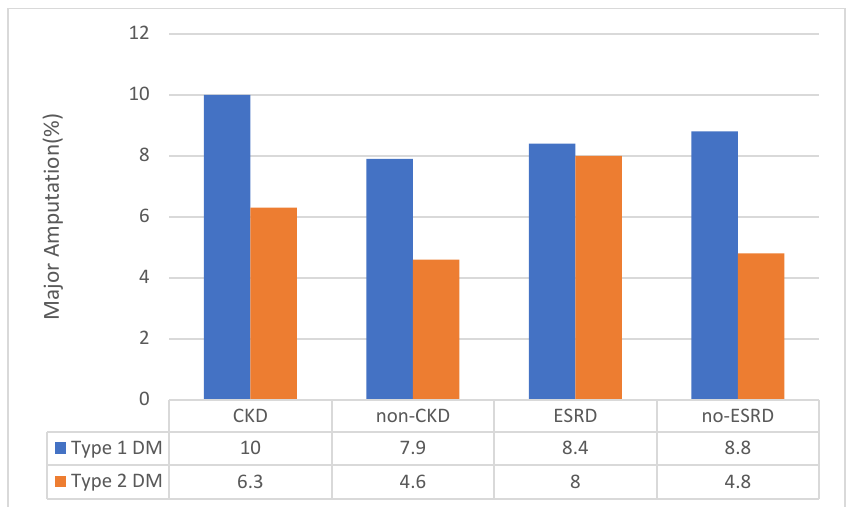
Figure 3. Proportion of type 1 and type 2 diabetes patients based upon presence and absence of CKD and ESRD that underwent amputation procedures. CKD, chronic kidney disease; DM, diabetes mellitus ; ESRD, end-stage renal disease.